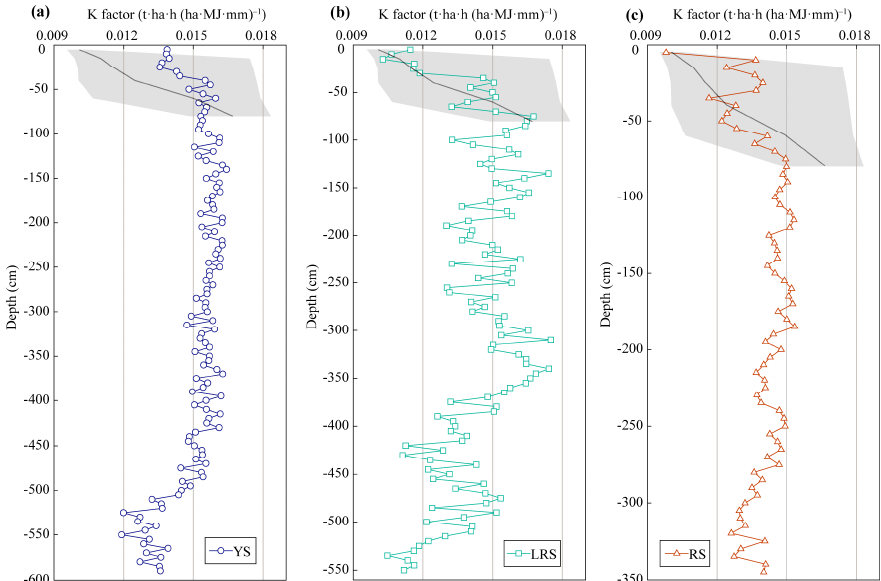
Figure 3. Soil erodibility K factor in soil profiles of YS ( a ), LRS ( b ), and RS ( c ) in the JRC. Black line in the 0–0.8 m layer indicates the average K factor at the same depth in the CC; the edges of shadow area are determined by maximum and minimum of K factors of them; the data are cited from [37].